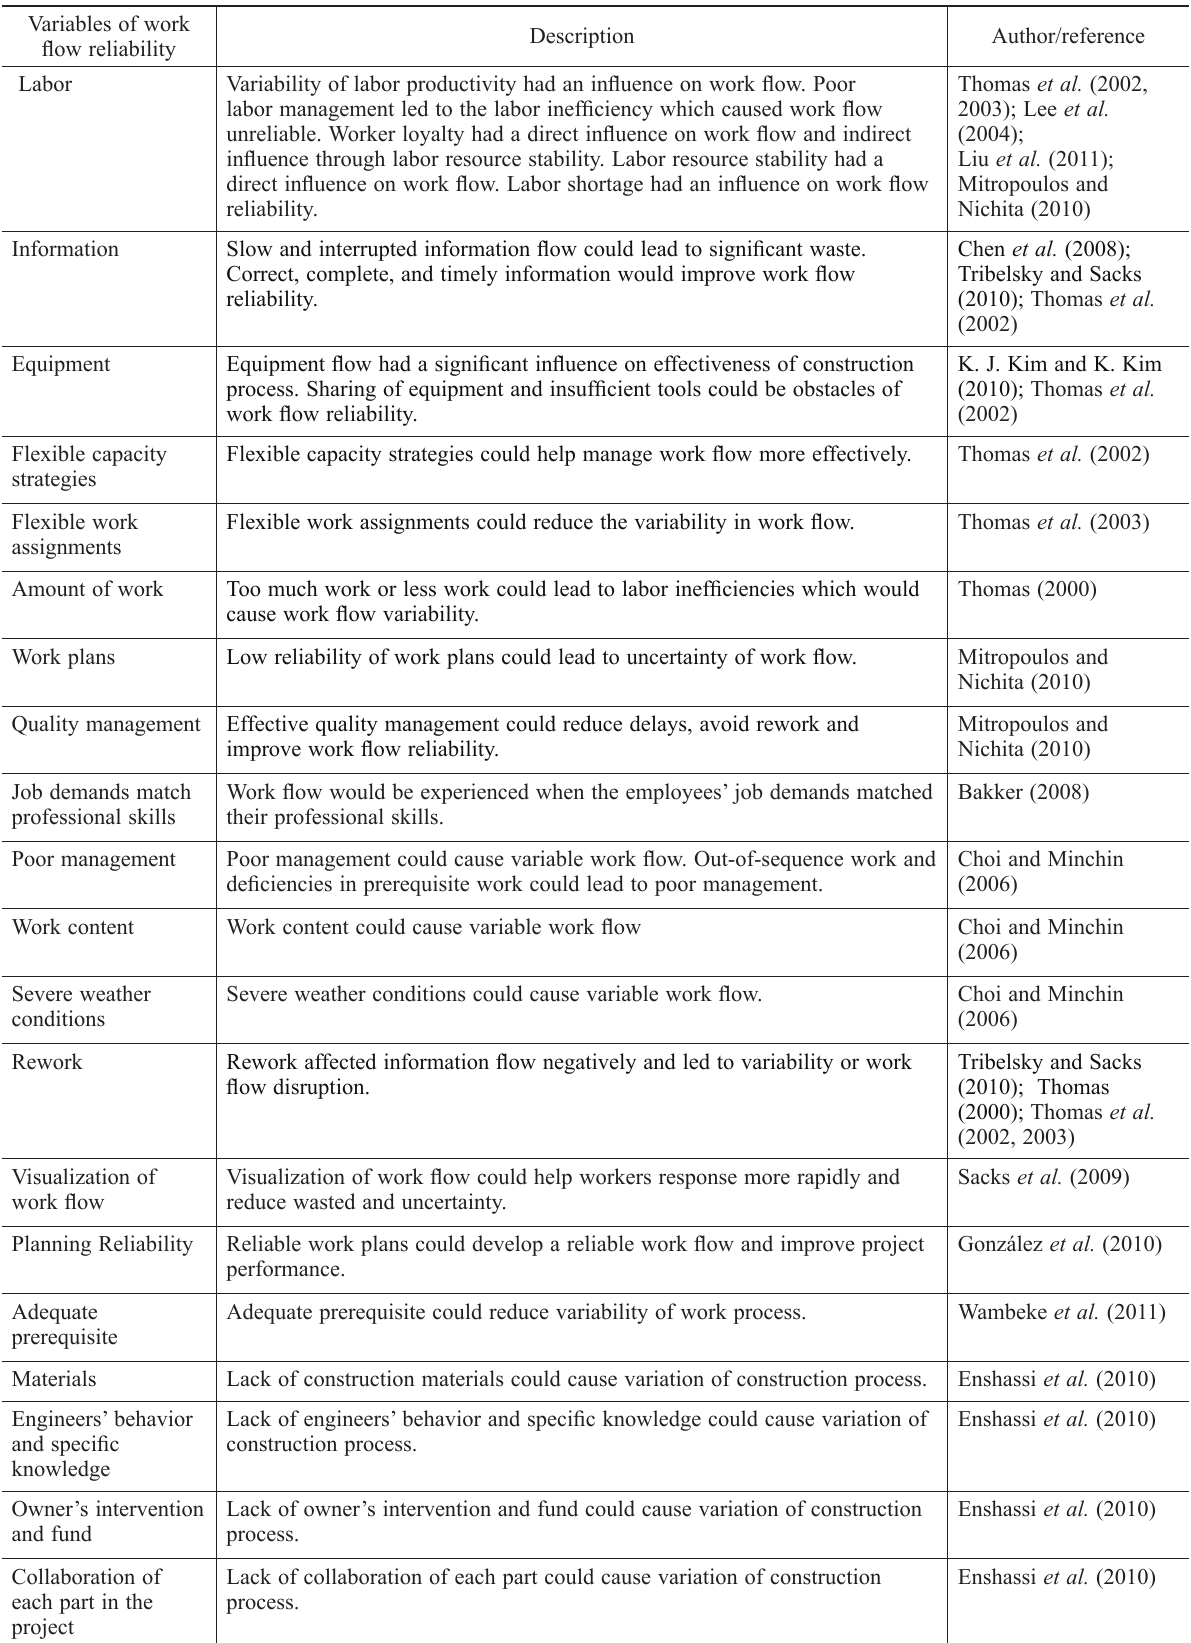
Table 1. Summary of the variables of work flow